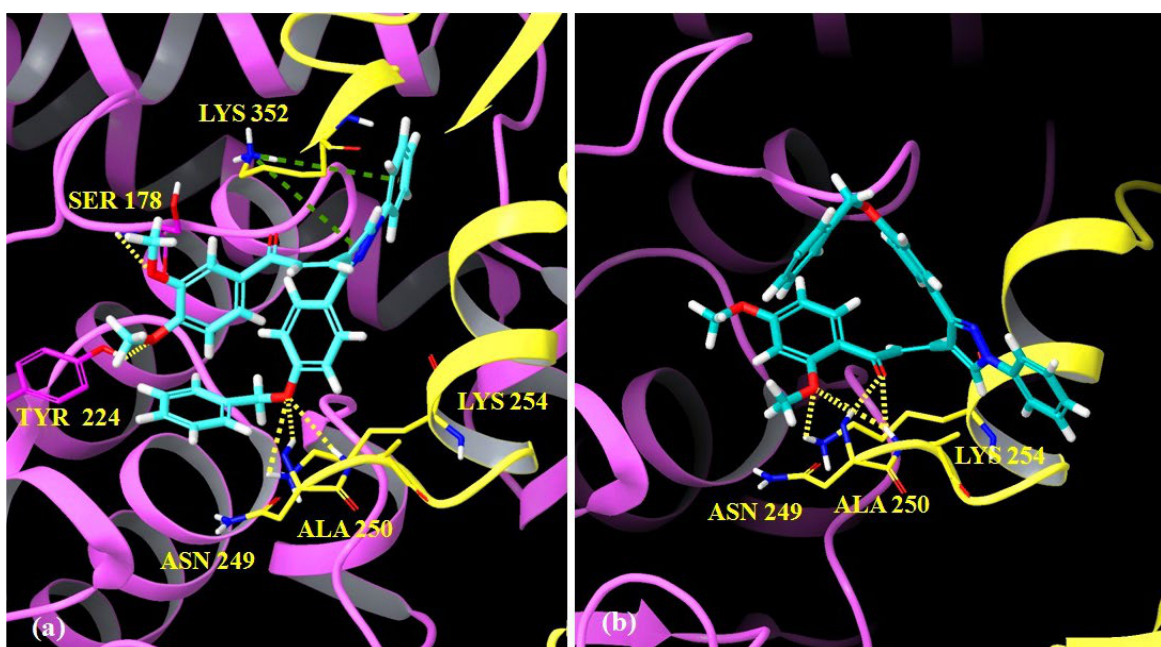
Figure 4. ( a ) Docked pose of compound 5o (turquoise color) showing hydrogen bond interaction (yellow dashed lines) with ASN 249, ALA 250, LYS 254, SER 178, and TYR 224; pi-cation interaction with LYS 352 in the colchicine-binding site of tubulin. ( b ) Docked pose of compound 5p (turquoise color) showing hydrogen bond interaction (yellow dashed lines) with ASN 249, ALA 250, and LYS 254 in the colchicine-binding site of tubulin. The α -chain is represented in a purple color cartoon and the β -chain is represented in a yellow color cartoon model.